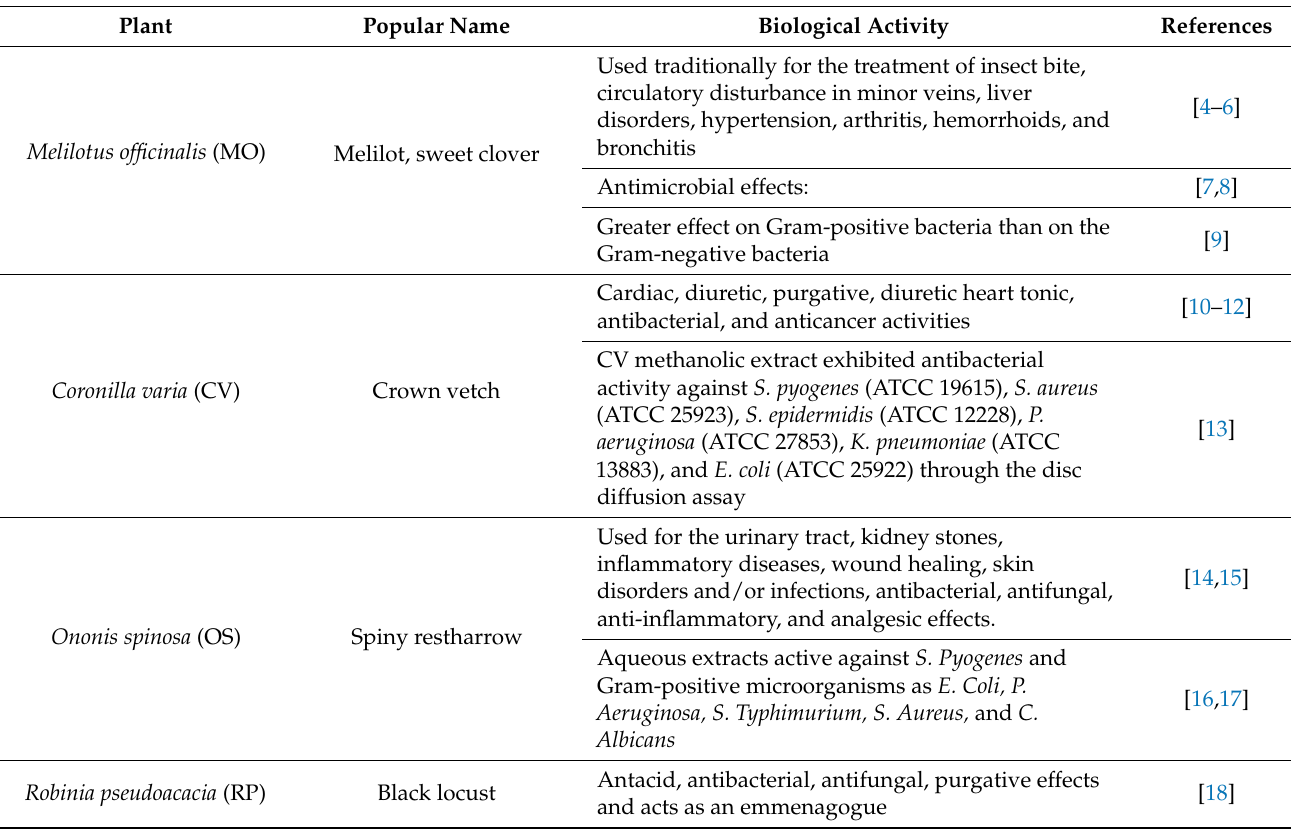
Table 1. The main activities of the investigated